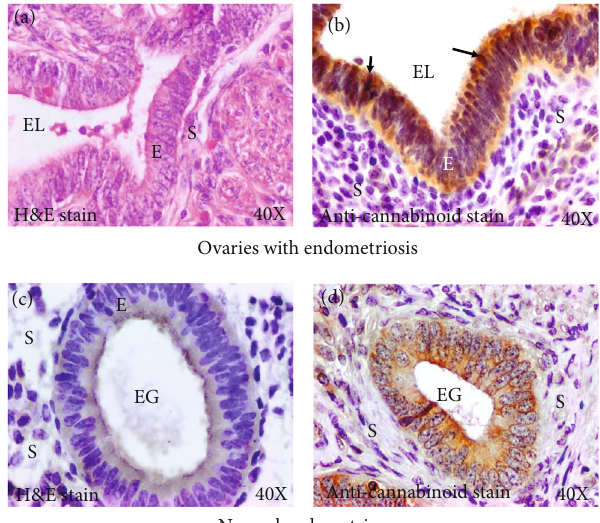
Figure 3: Expression of cannabinoid receptor 1 (CB1) by the epithelial cells or stromal cells in ovaries with endometriosis. (a) Section of an ovary with endometriosis stained with hematoxylin and eosin showing lesions with glands. (b) Section of an ovary with endometriosis showing intense expression for CB1 by epithelial cells of endometriotic lesions (EL). (c) Section of a normal endometrium showing an endometrial gland (EG) containing a single layer of epithelium. (d) Section of a normal endometrium showing moderate expression for CB1. E =epithelium; EG=endometrial glands; EL =endometriotic lesion; S =stroma; 40x=magni fi cation. Arrows indicate examples of immunopositive CB1 cells.